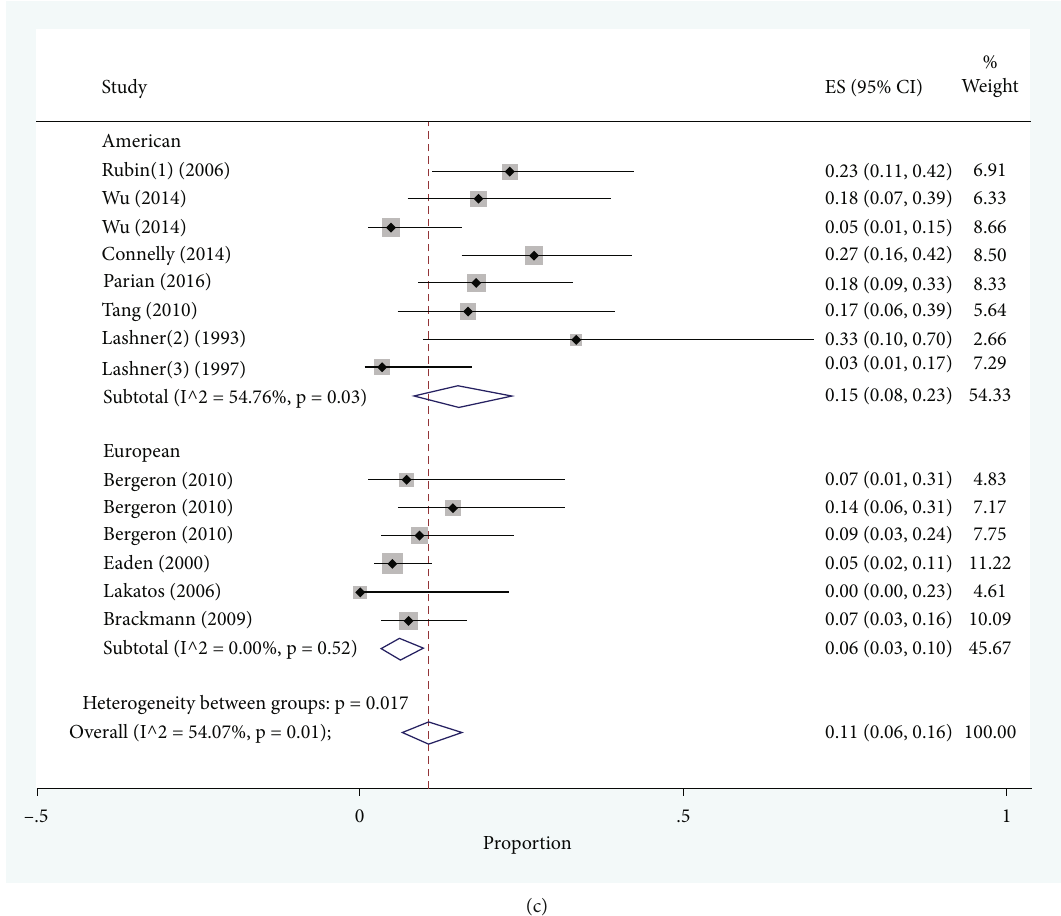
Figure 3: Forest plot for the prevalence of family history of IBD among dysplasia or CRC patients: (a) overall prevalence; (b) prevalence by degree of relative; (c) prevalence by region of